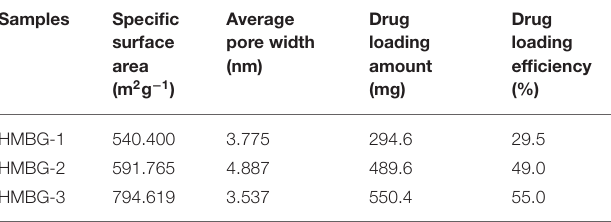
TABLE 1 | The microstructure and drug loading ability of HMBG nanoparticles. Samples Specific